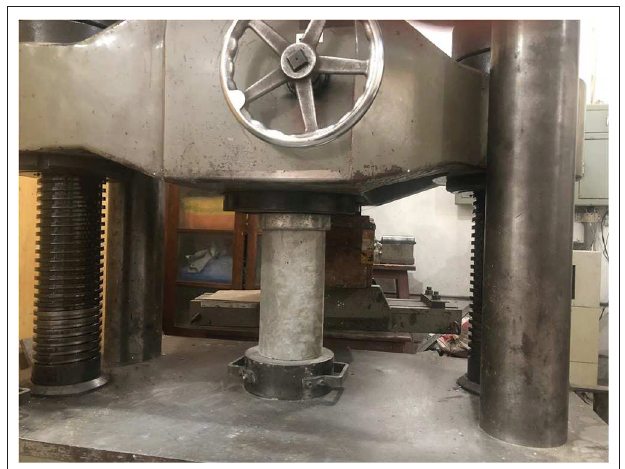
FIGURE 6 | Test setup used to measure the compressive strength of concrete